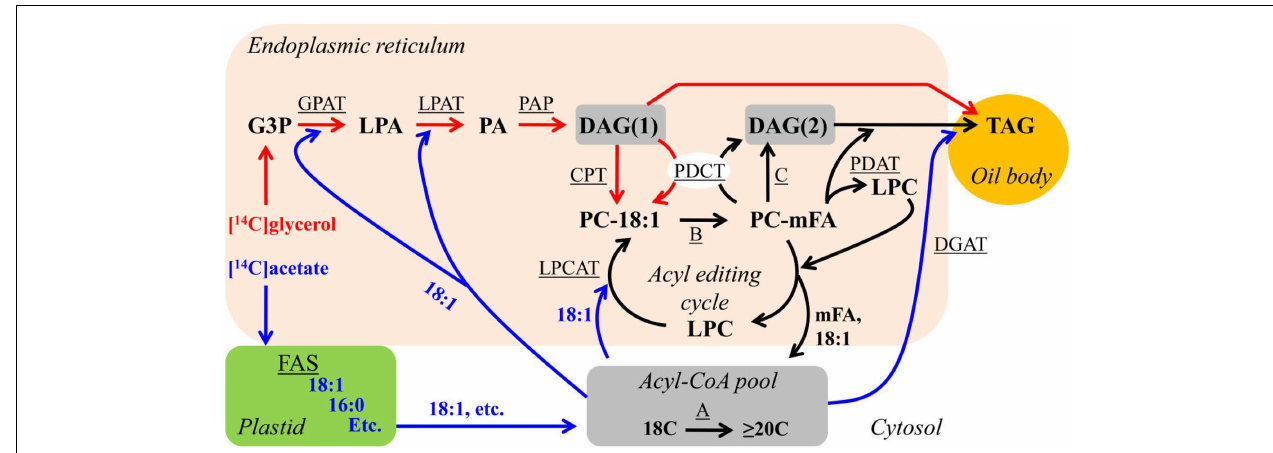
TAG, triacylglycerol. Enzymatic reactions are underlined: A, FA elongation; B, modification of FA esterified to PC; C, reversible CPT or phospholipase C or phospholipase D/PAP DAG production. CPT, CDP-choline:DAG cholinephosphotransferase; DGAT, acyl-CoA:DAG acyltransferase;